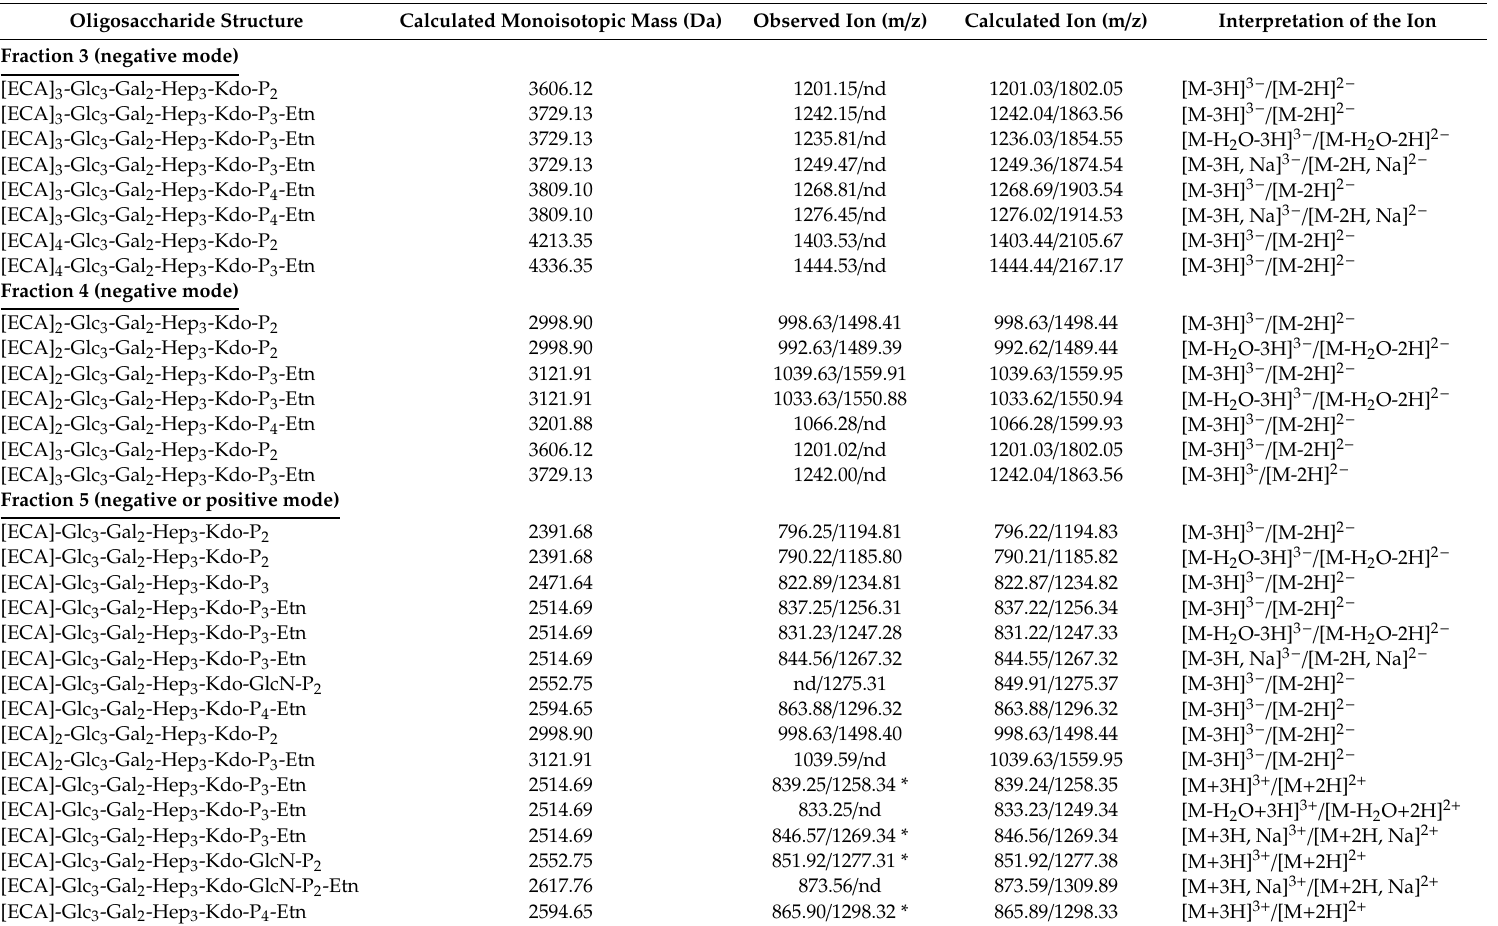
Table 1. Interpretation of ESI-IT mass spectra of fractions 3–5 isolated from E. coli R1 LOS